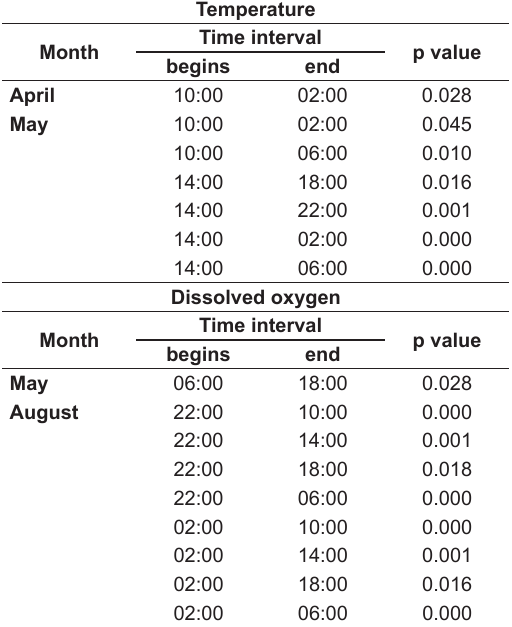
Table 2. Results for Tukey’s t-test: time periods in a given month where significant differences in temperature, dissolved oxygen and conductivity were encountered in Lago Catalão.